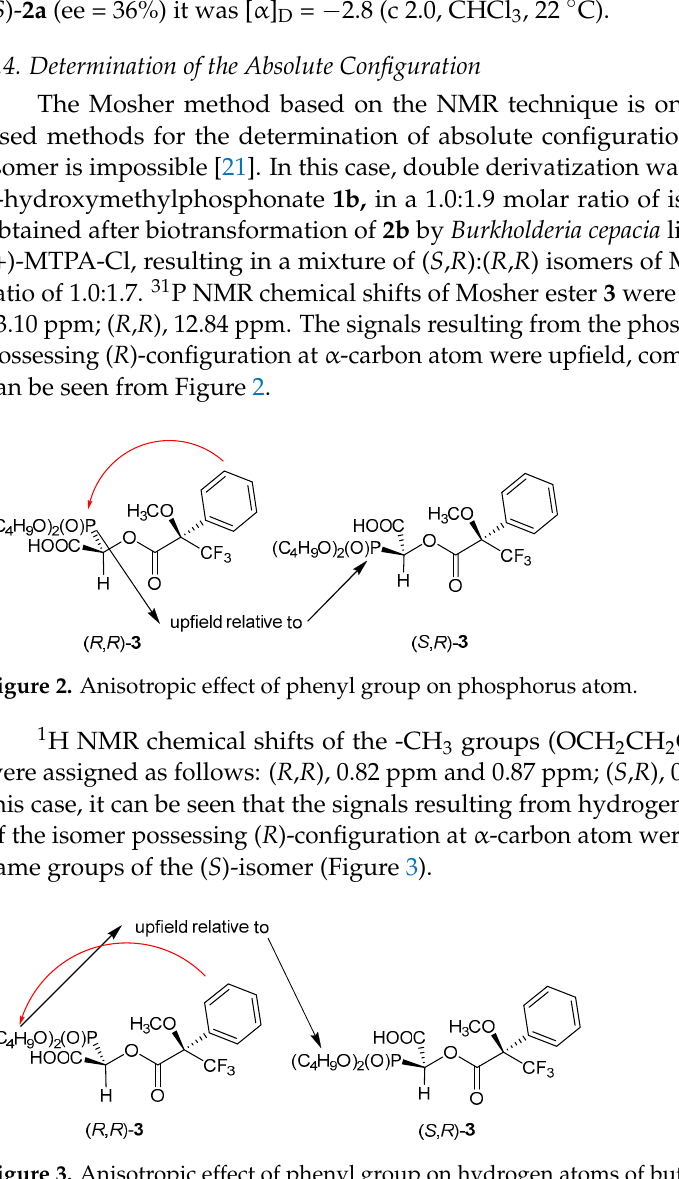
1 H NMR chemical shifts of -OCH 3 groups of compound 3 were assigned as follows: